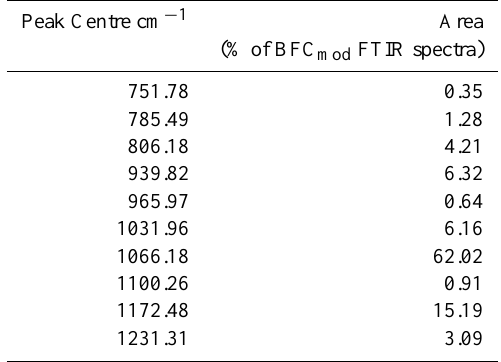
Fig. 1. Example of gaussian peak fitting (red curves) for the BFC mod FTIR spectra (Table 1). The resultant fitted model is sub- sequently used to develop the BFC mod – “Silt” mass-balance cali- bration.